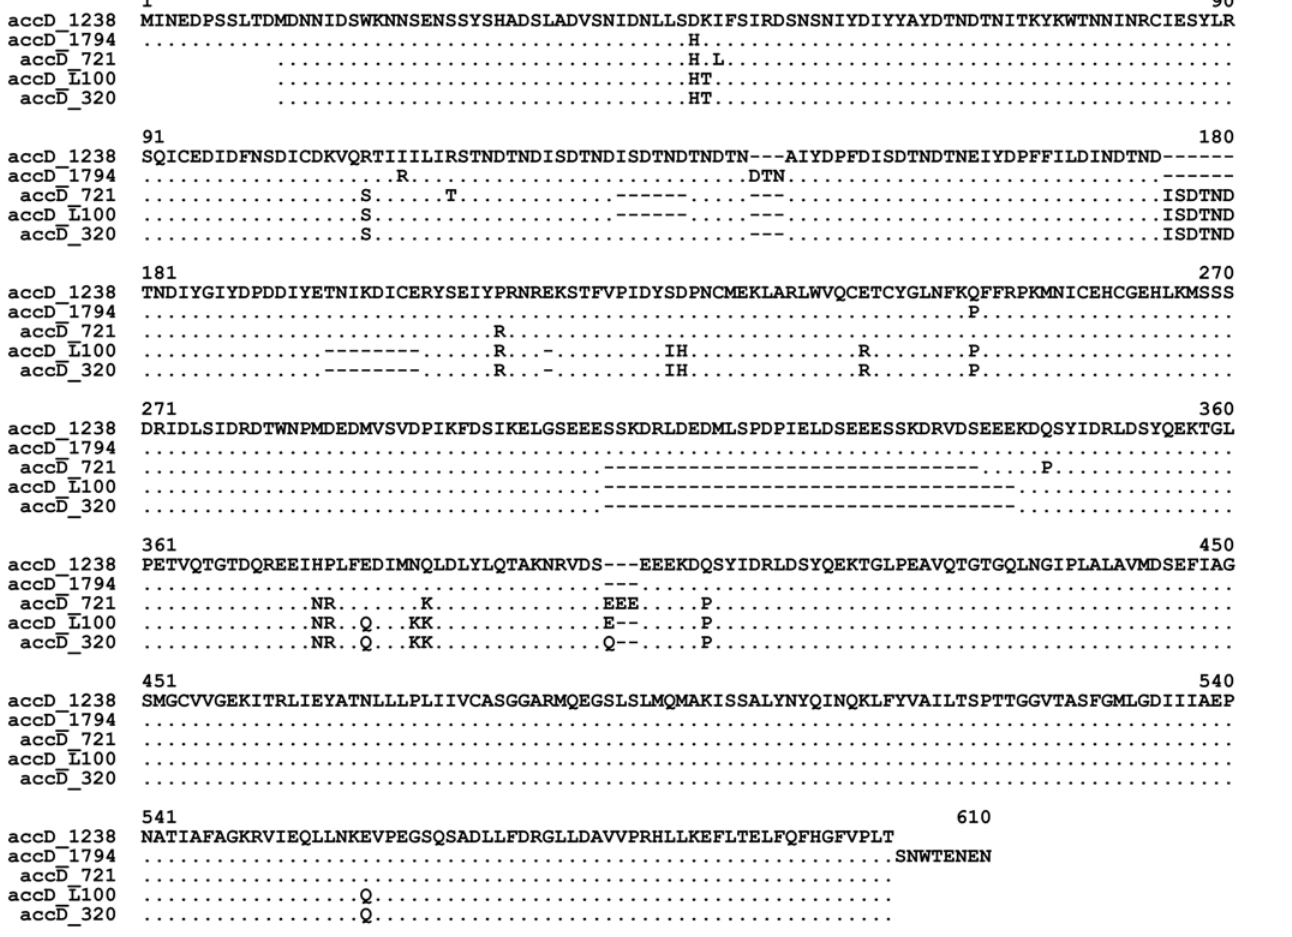
Fig 2. Alignment of the derived amino acid sequences encoded by accD alleles of the accessions studied. Dots indicate amino acid residues identical to those of WL1238. Dashes stand for deletions.